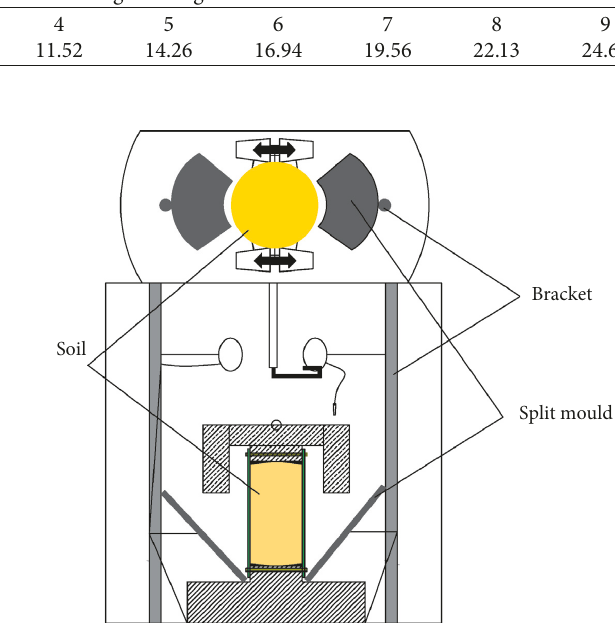
Figure 13: Schematic diagram of process ⑥ .